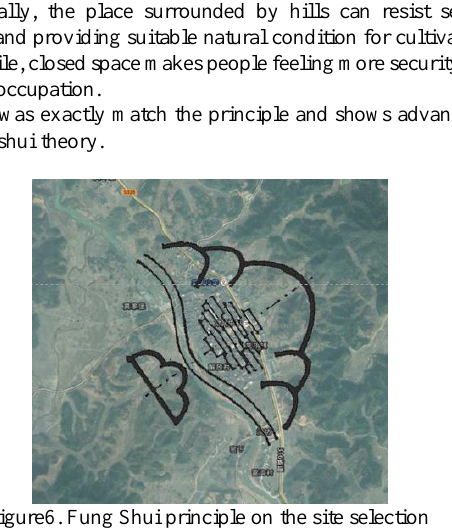
Figure10. The Profile of Bafujun ancestral hall in Tangyin (Picture source: Shao Zengze, 1982 )